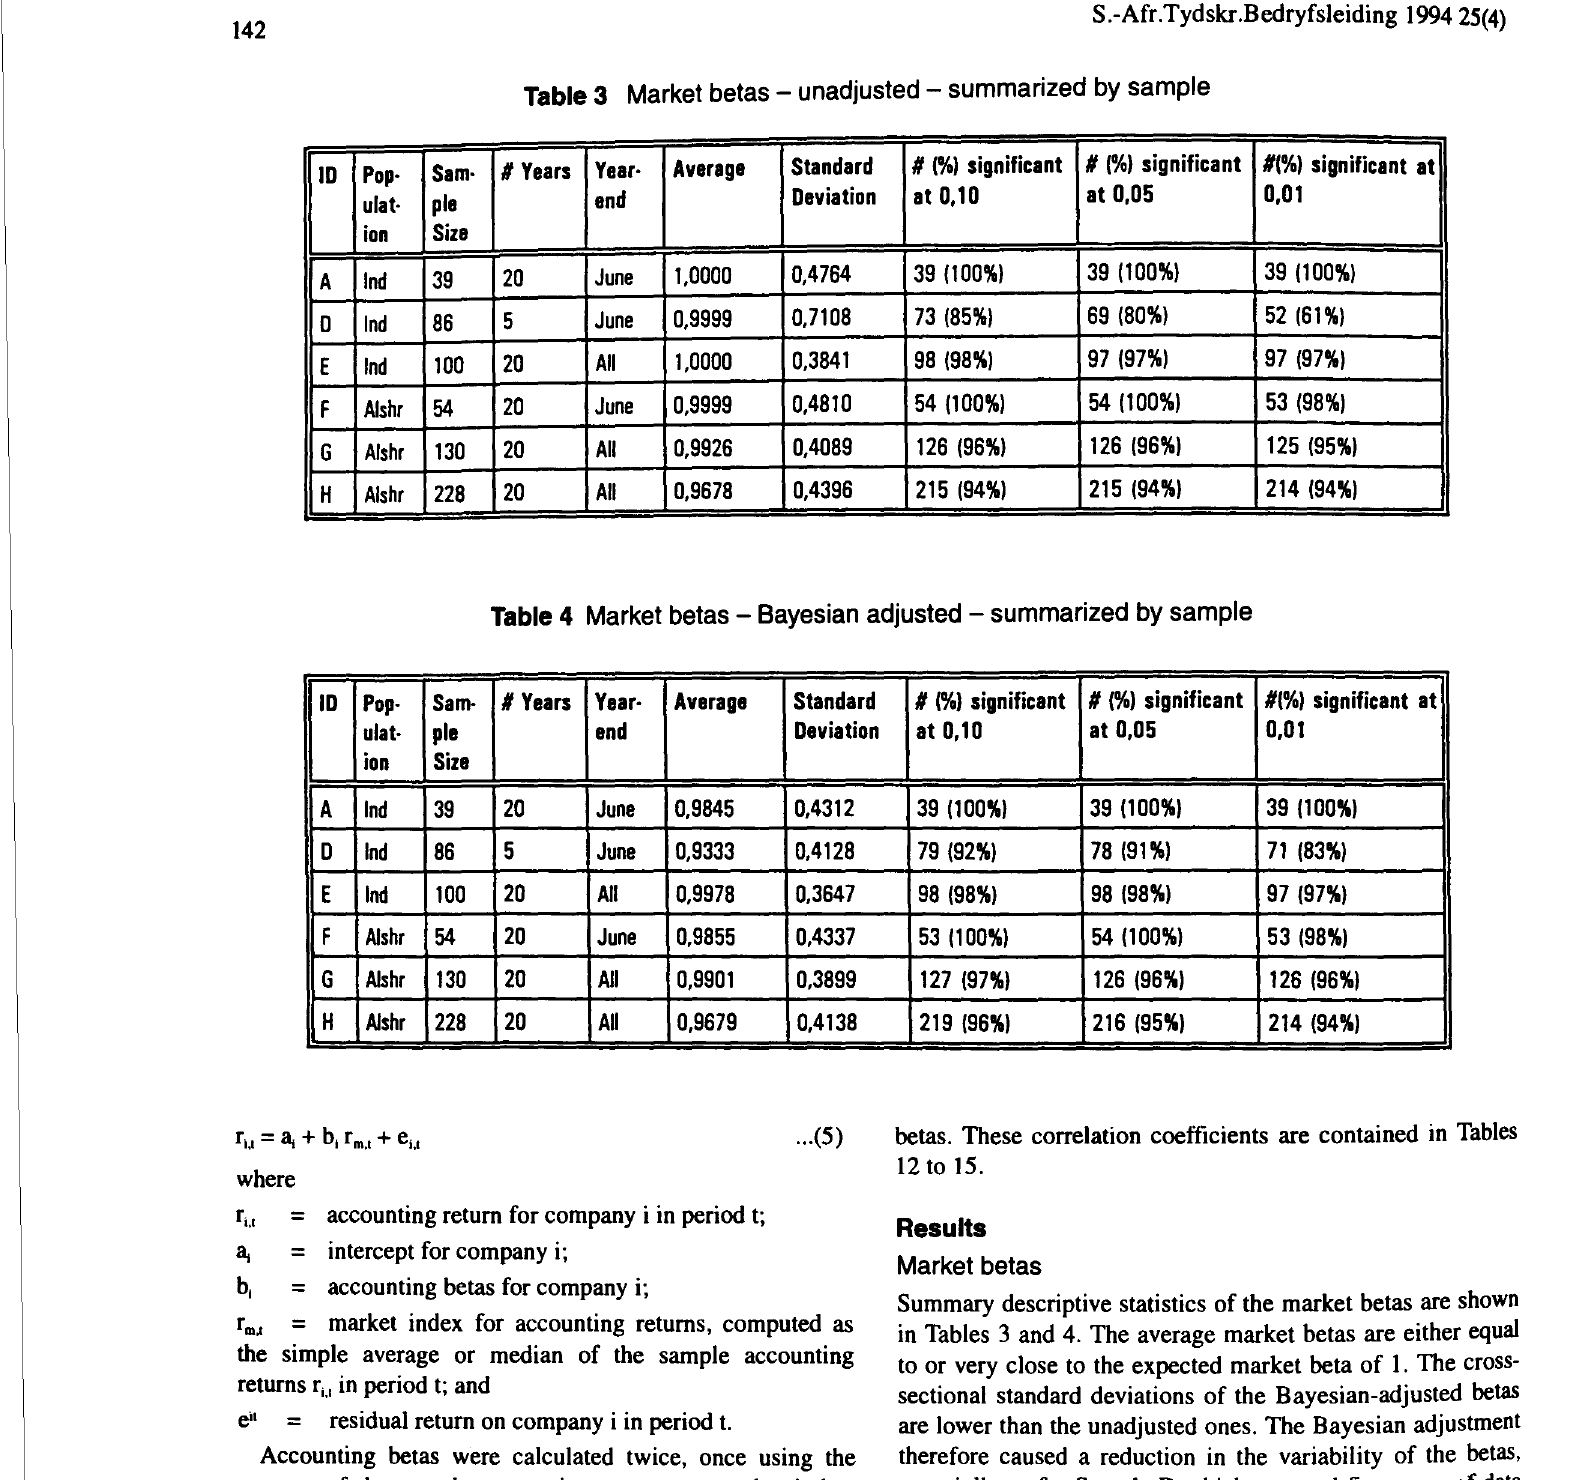
Table 3 Market betas - unadjusted - summarized by sample